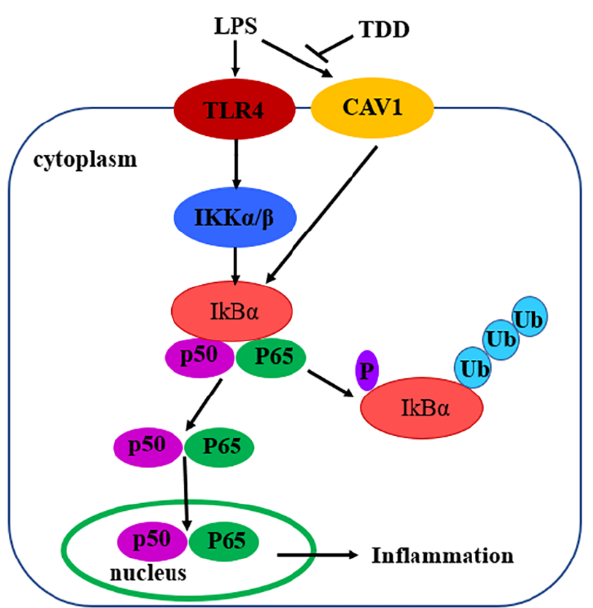
Figure 10. Diagram of the possible mechanisms of TDD-induced effects in LPS-stimulated EA.hy926 Cells.